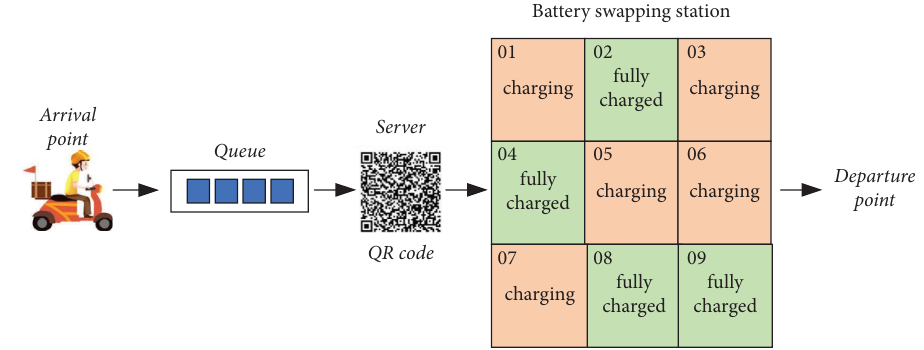
Figure 7: Diagram of the battery swapping